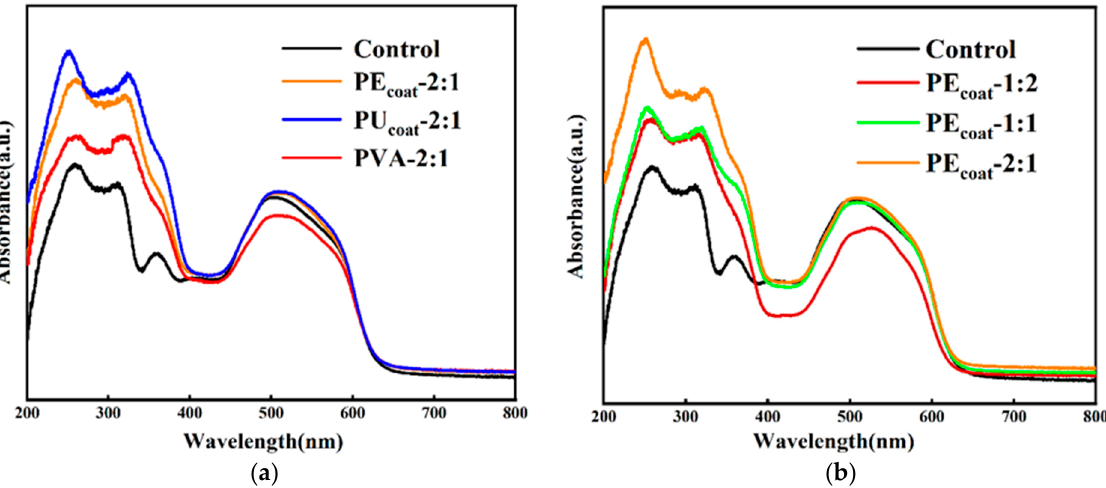
Figure 8. UV-visible absorption results of pigments coated under different conditions: ( a ) different types of binders; ( b ) different ratios of polyester varnish to TiO 2 .